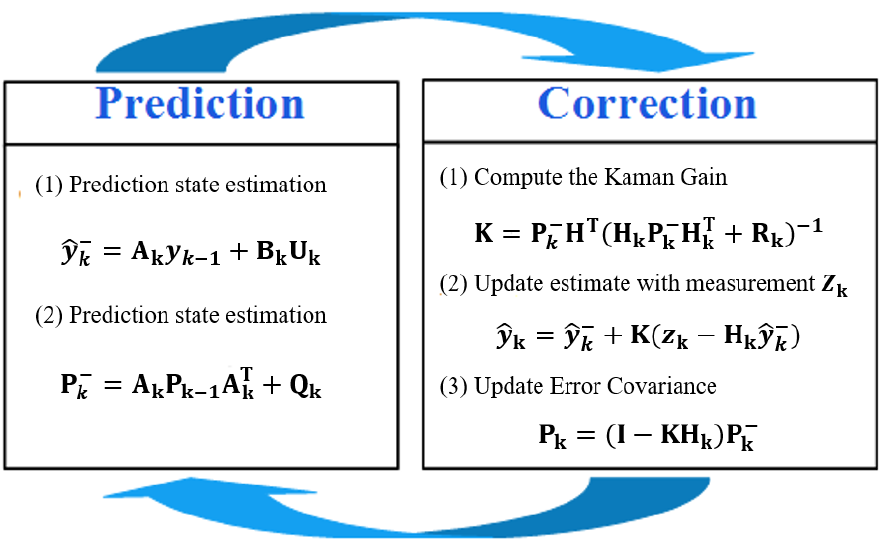
Figure 19. Kalman Filter prediction and correction